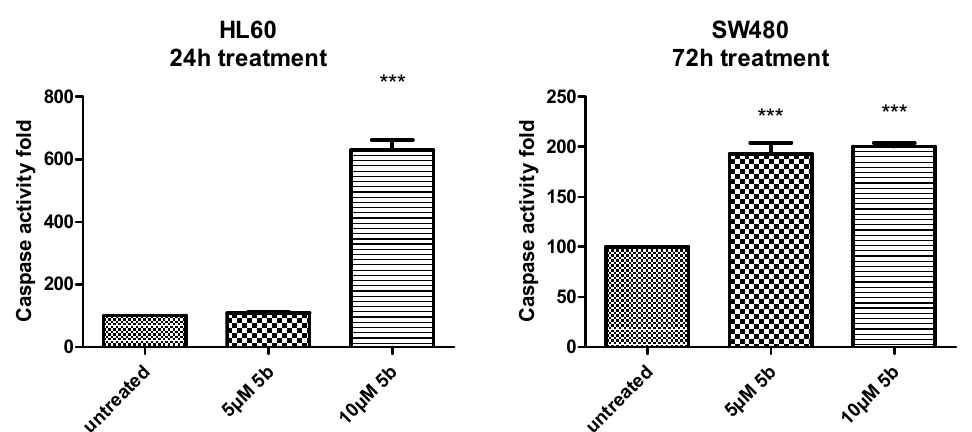
Figure 8. Caspase assay of HL60 and SW480 cells after treatment. Particularly strong activation of caspases was observed in HL60 cells treated with 10 µM of compound 5b . Significance was designated as *** for P < 0.001. Error bars depict ± SD.